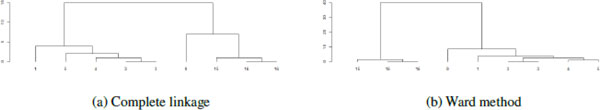
Agglomeration Methods. An illustration of the difference between (a) complete linkage and (b) the Ward method of agglomeration. When merging 3 groups into 2 using complete linkage, 16 - 9 = 7 > 9 - 1 = 8, so 9 is grouped with the larger numbers. Using the Ward method, the groups {1, 3, 3, 4, 5}, {9, 15, 16, 16} produces an ESS2 = 42.8, while {1, 3, 3, 4, 5, 9}, {15, 16, 16} produces ESS2 = 37.5, so the second merge strategy is used.